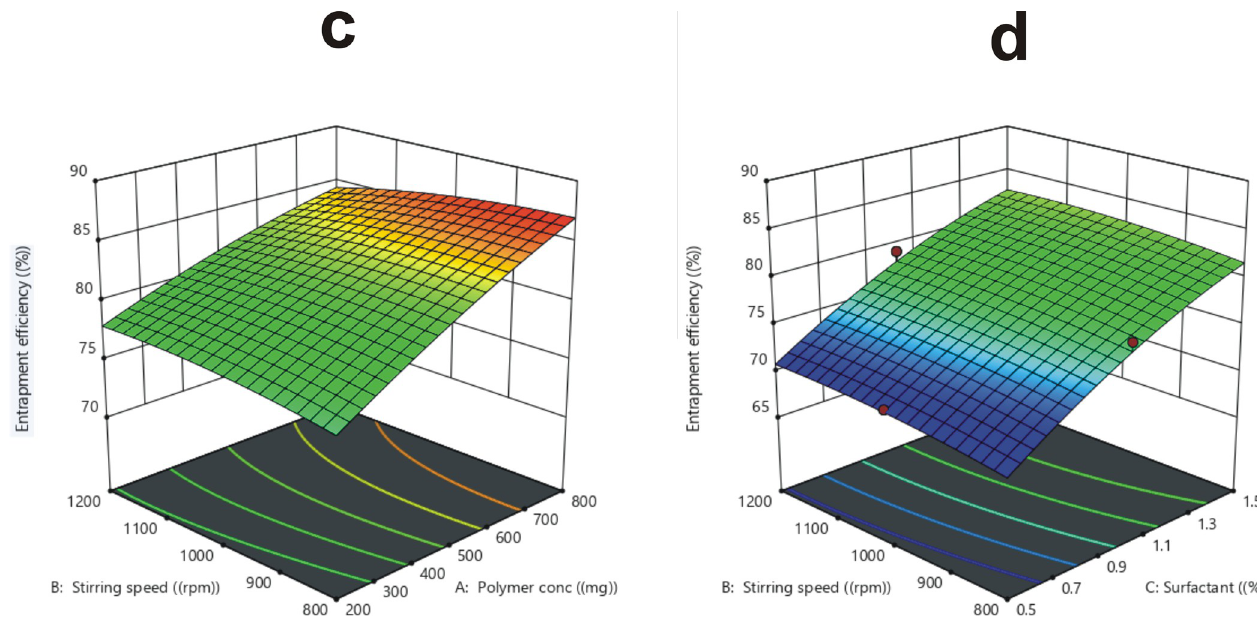
Fig 2. The influence of stirring speed and polymer concentration on EE (c), the influence of stirring speed and surfactant concentration on EE (d).